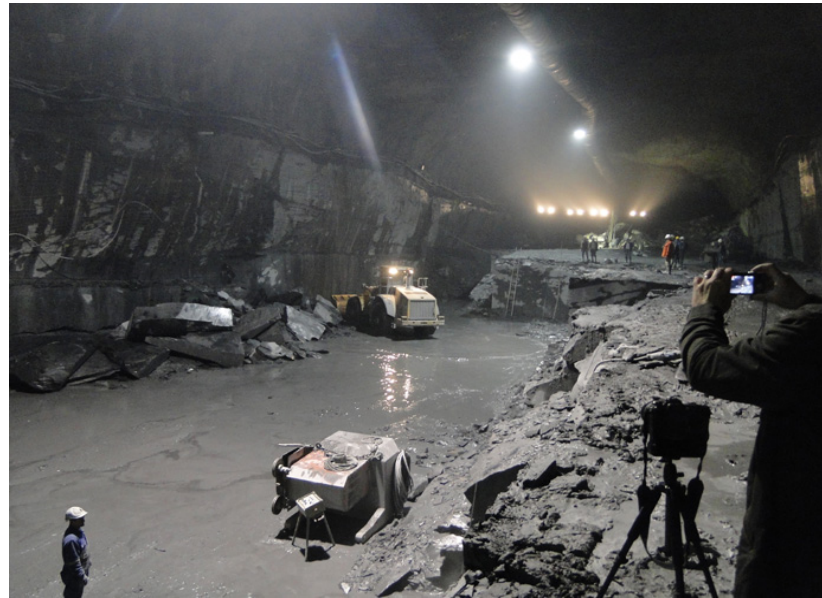
Minerals 2020 , 10 , x FOR PEER REVIEW Figure 3. Underground slate mining in Spain (Valdeorras, Casaio-formation). Figure 3. Underground slate mining in Spain (Valdeorras, Casaio-formation).